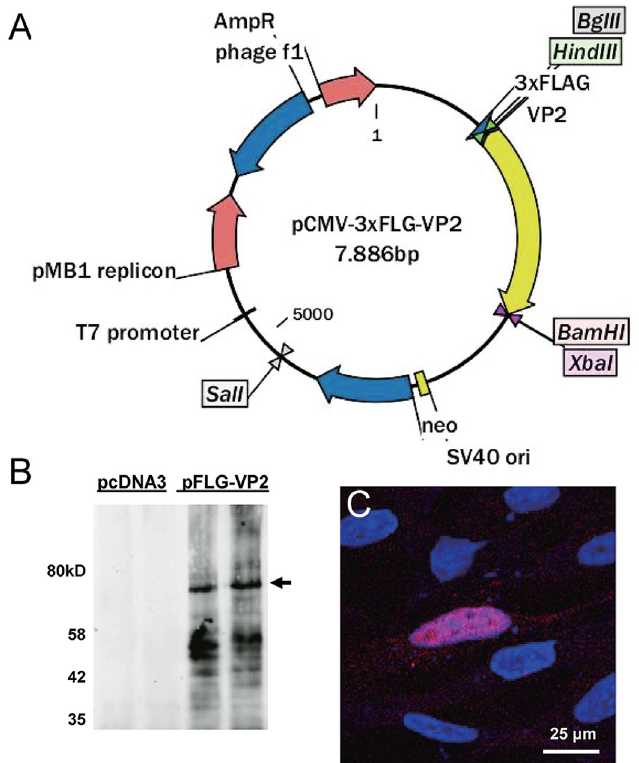
Fig 1. Construction of the FLAG-VP2 fusion expression plasmid. (A) The vector map of pCMV- 3×FLG-VP2. (B) Identification of FLAG-VP2 expression in 293 cells by western blot analysis using primary anti-FLAG antibody and IR700 labeled fluorescence secondary antibody at 24 h post transfection. (C) Immuno-staining of FLAG-VP2 in CHO cells transfected with pCMV-3×FLG-VP2 at 48 h using an anti-FLAG polyclonal